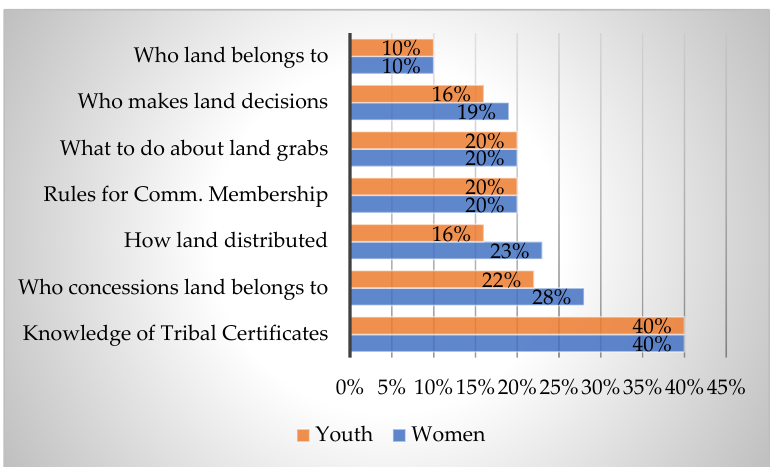
Figure 2. Youth and women who “Don’t Know” about land rights under the Land Rights Act.